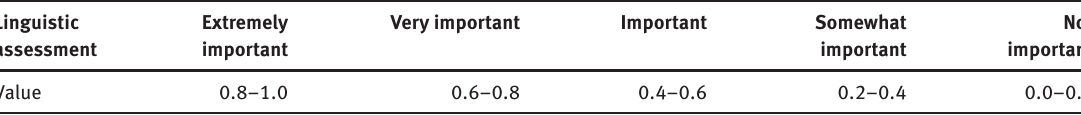
Table 1: The Relationship Between Fuzzy Language Variables and Numerical Interval.